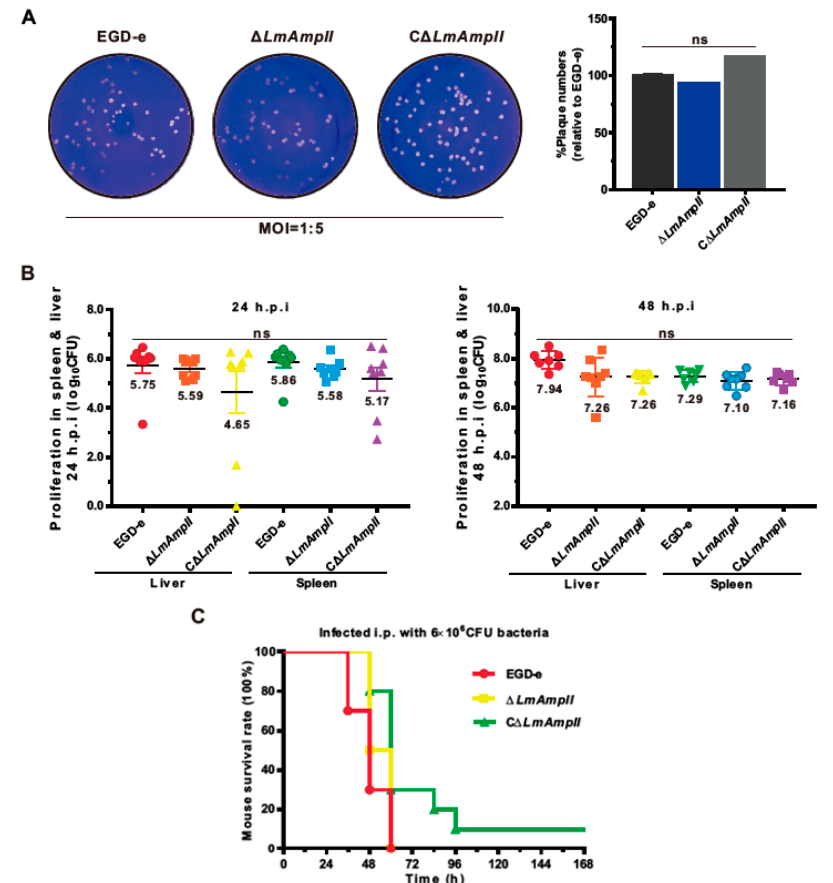
Figure 5. LmAmpII was not essential for L. monocytogenes virulence in the mouse model. ( A ) Plaque assay performed on L929 fibroblast monolayers infected by L. monocytogenes . The plaque numbers of the mutant strains were indicated as a percentage of those formed by the wild-type strain. ( B ) Proliferation of L. monocytogenes in mice organs. Mice were inoculated intraperitoneally with 2 × 10 6 CFU bacteria, and animals were euthanized 24 and 48 h post-infection (h.p.i), and numbers of bacteria colonized in organs shown represent the mean ± SD of the log 10 cfu per organ for each group. ( C ) Kaplan–Meier survival of the infected ICR mice over time. The mice were challenged intraperitoneally with 2 × 10 6 CFU bacteria and monitored for up to 7 days post-inoculation. Data shown represented as the percentage survival over time and significance was determined via a Log-rank test. ns, not significant.